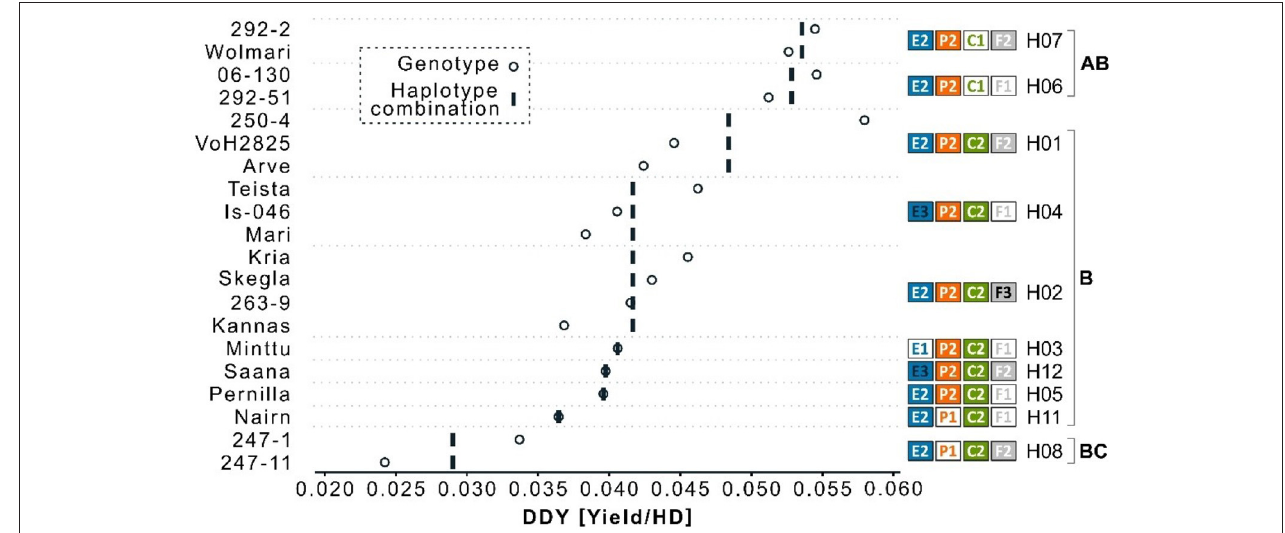
FIGURE 2 | Index values of yield by heading day (DDY) for 20 barley genotypes. Open circles indicated DDY for each genotype. Vertical bands indicate the mean per haplotype combination. Haplotype combinations for the four flowering loci HvELF3 (blue, E), Ppd-H1 (orange, P), HvCEN (green, C), and HvFT1 (gray, F) are shown to the right of the diagram. Tukey’s test for significance resulted in a significant difference between haplotype H08 and H07/H06 ( p = 0.03) and is indicated with the letters to the far